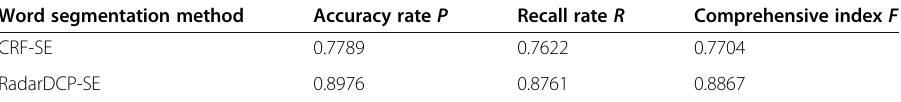
Table 2 Comparison results between CRF-SE and RadarDCP-SE on texts of radar defects